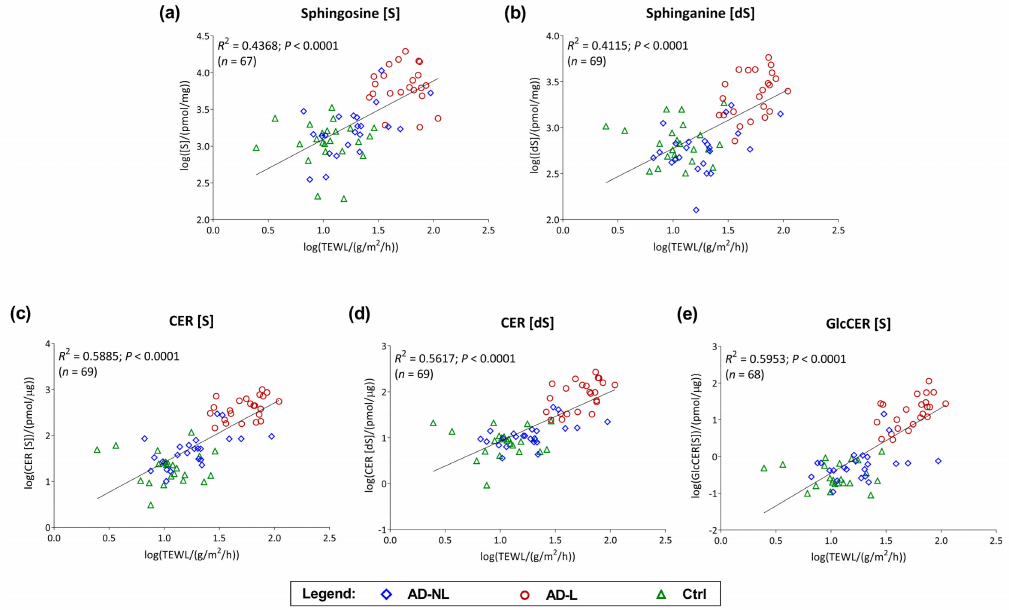
Figure 6. Linear regression analysis for the relationship between trans-epidermal water loss (TEWL) and ceramide markers ( a ) sphingosine, (S); ( b ) sphinganine, (dS); ( c ) CER, (S); ( d ) CER, (dS); and ( e ) glucosylceramide, GlcCER (S) in the SC of AD patients and healthy controls (Ctrl). NL = non-lesional skin; L = lesional skin. Data were log-transformed prior analysis. a p -value < 0.05 was considered